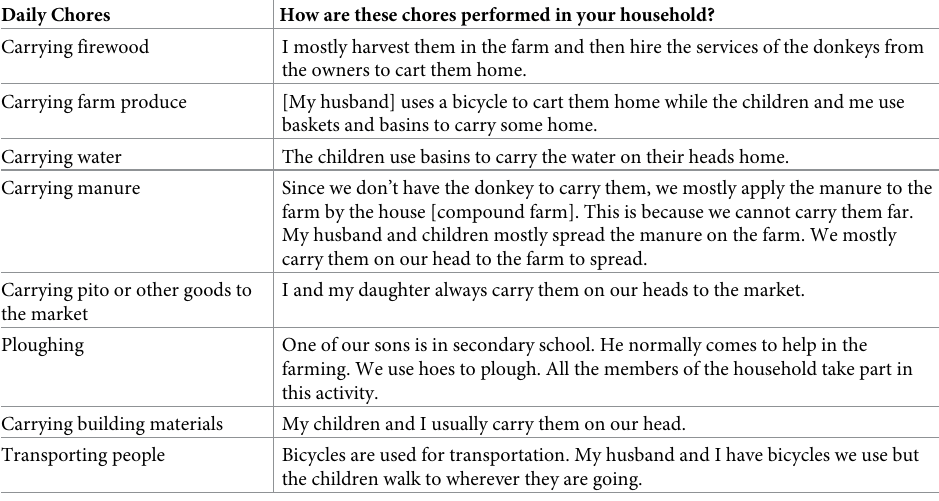
Table 3. How one non-donkey owning family undertake key daily tasks. Source: Maggs, 2022 [1]. Daily Chores How are these chores performed in your